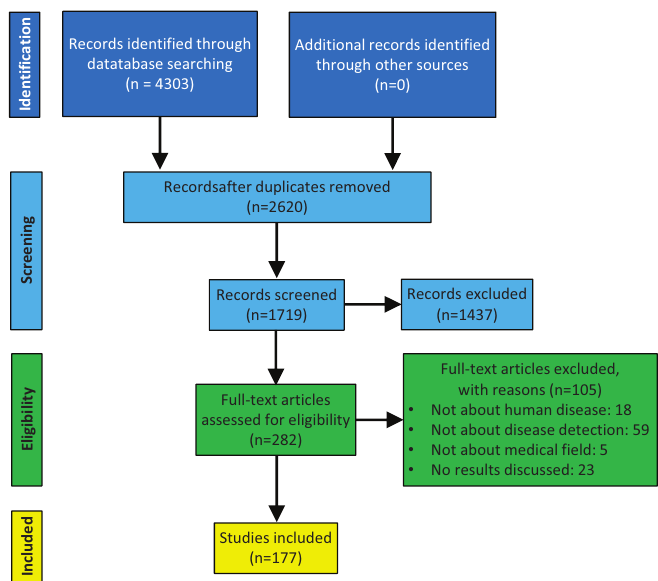
Figure 1. Flow diagram of search strategy and study